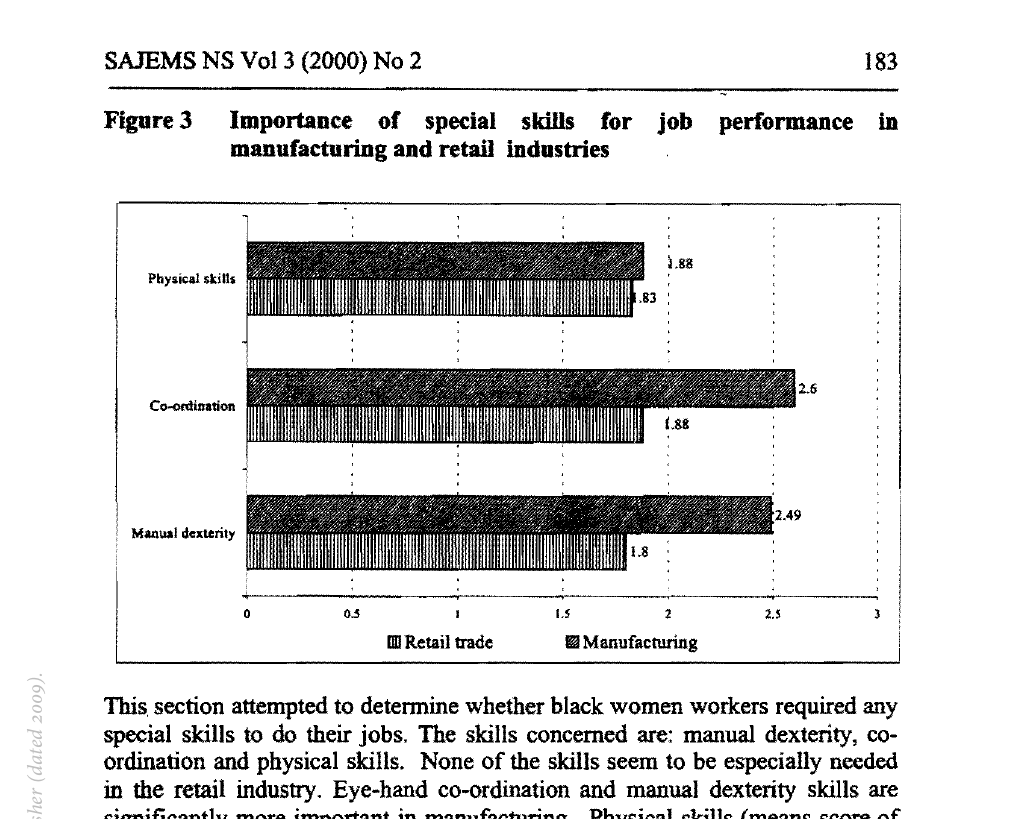
Figure 3 Importance of special skills for job performance in manufacturing and retail